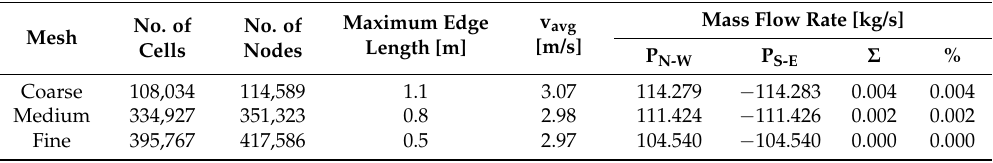
Table 2. The overview of the test meshes.